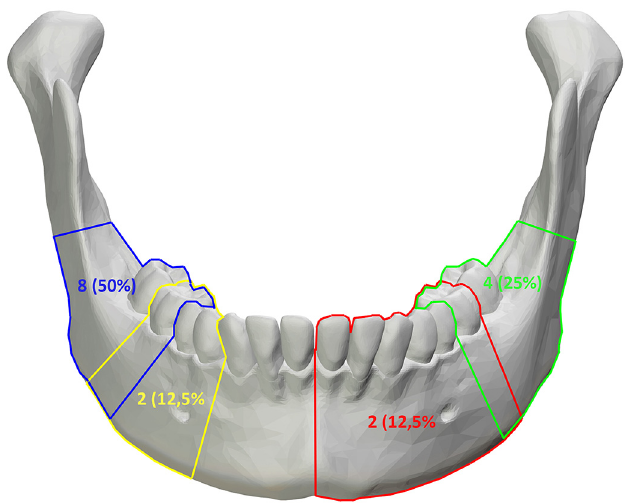
Fig. 2. OKCs presentation.